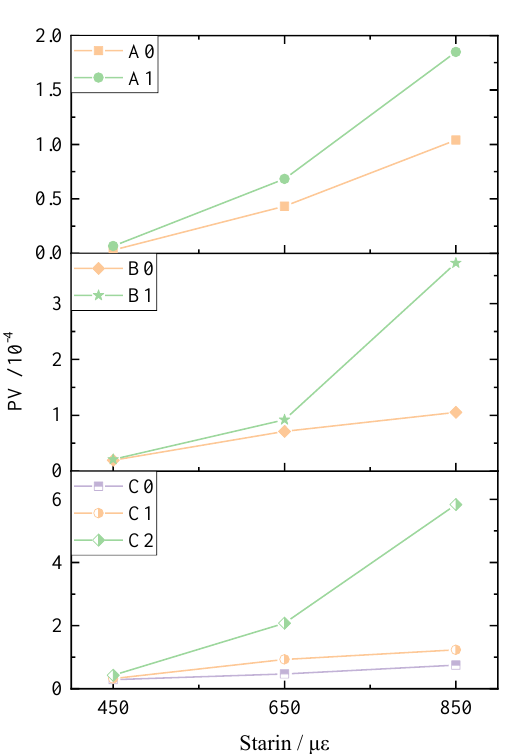
Figure 10. PV of the mixtures.